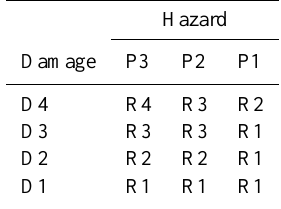
Table 3. Risk classes obtained through the matching between haz- ard scenarios and values given to different land use